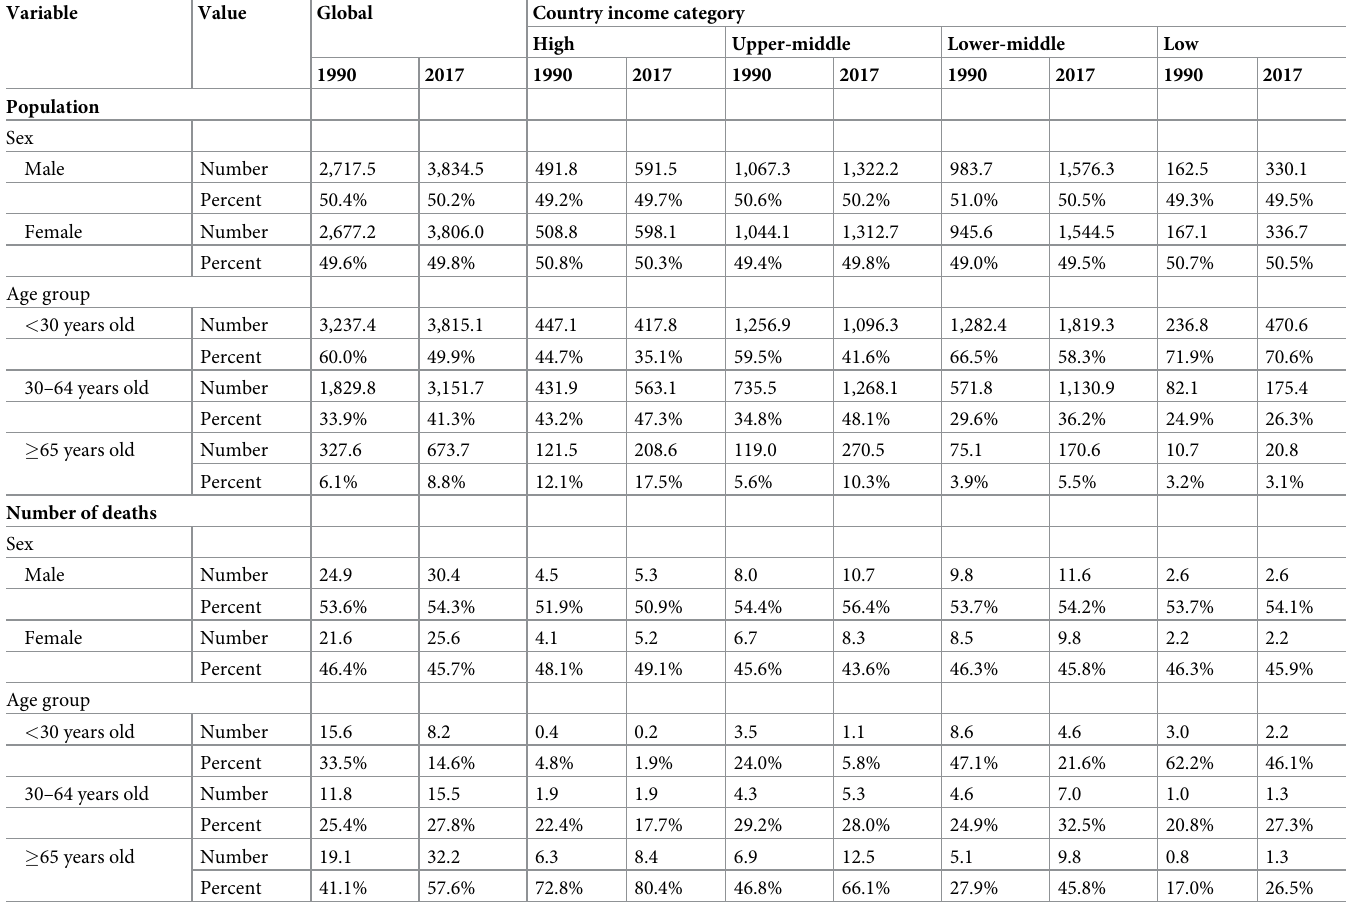
Table 1. Number of population (in millions) and deaths (in millions) in 1990 and 2017 globally and by country income category.